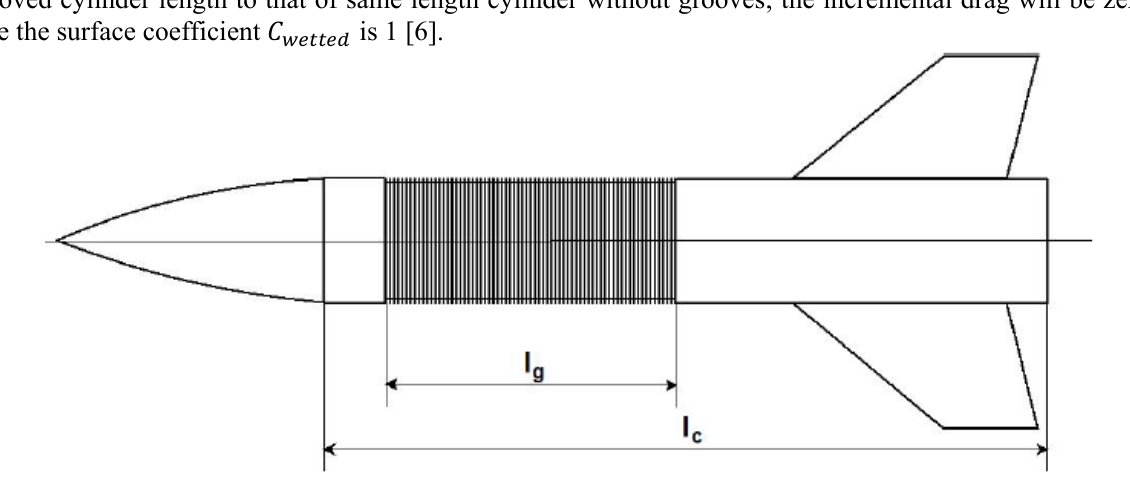
Figure 4. Groove pattern area on the surface of the cylindrical part of body